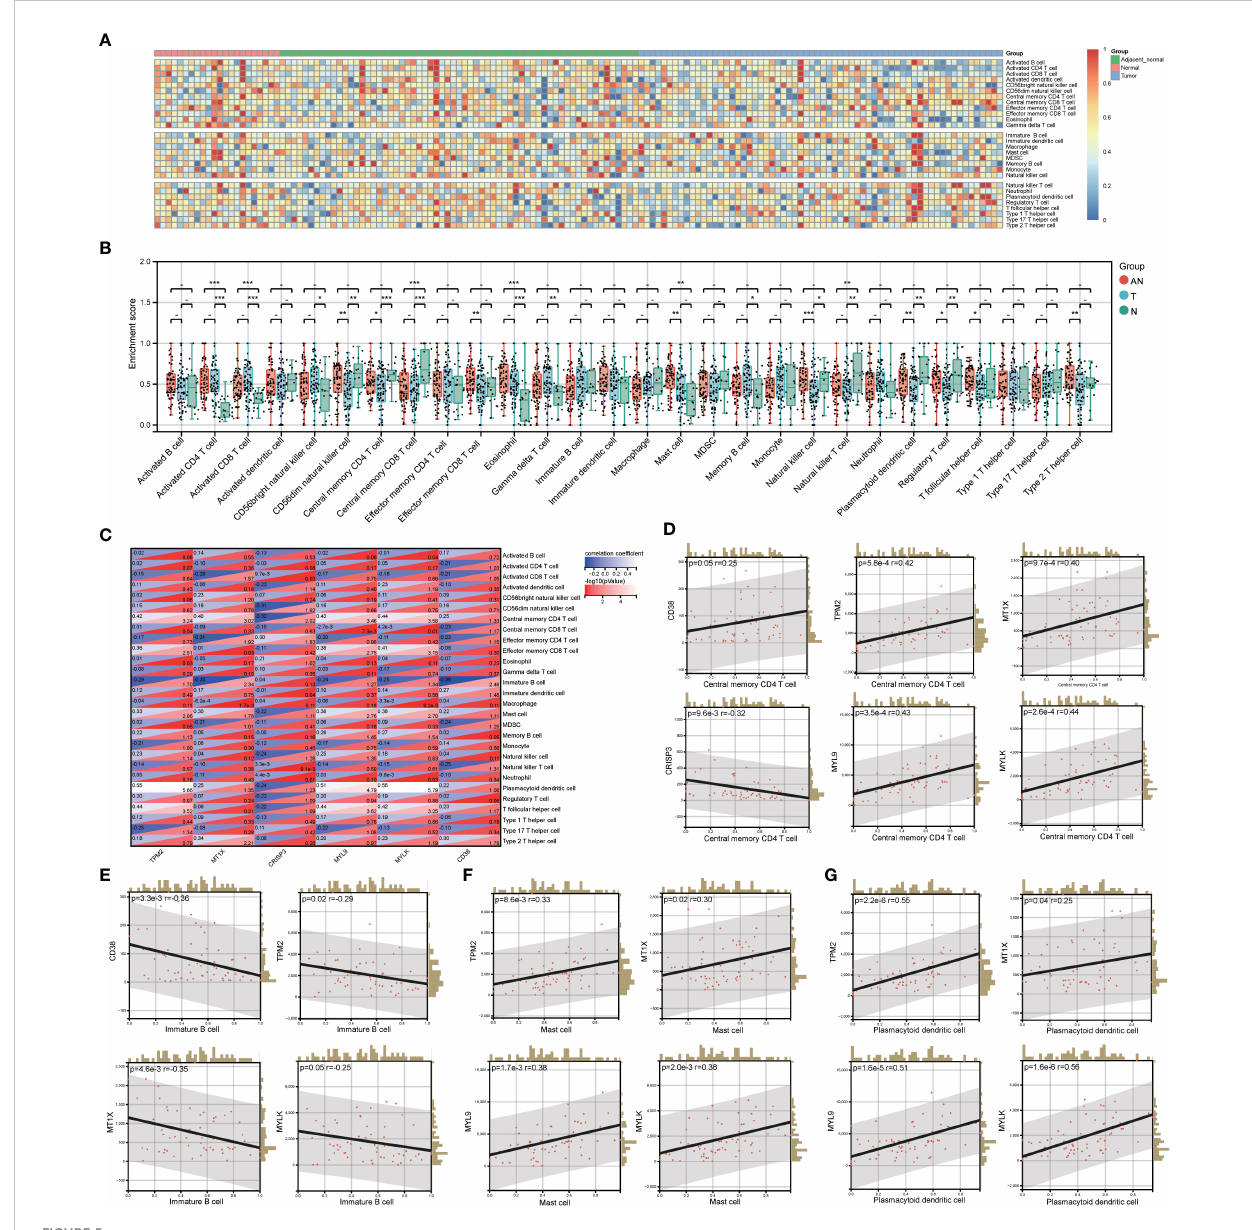
FIGURE 5 Evaluation of LRHG and immune microenvironment. (A) Heatmap of the landscape of 28 immune cell subpopulations in fi ltration in prostate; (B) Comparison of immune cell composition in Tumor, adjacent normal and nomal; (C) Heat map of the relationship between LRHG and 28 immune cells; (D-G) . The correlations between LRHG and Central memory CD4 T cell, Immature B cell, Mast cell, Plasmacytoid dendritic cell, respectively. * P < 0.05; * * P < 0.01; *** P < 0.001. -: no relevant